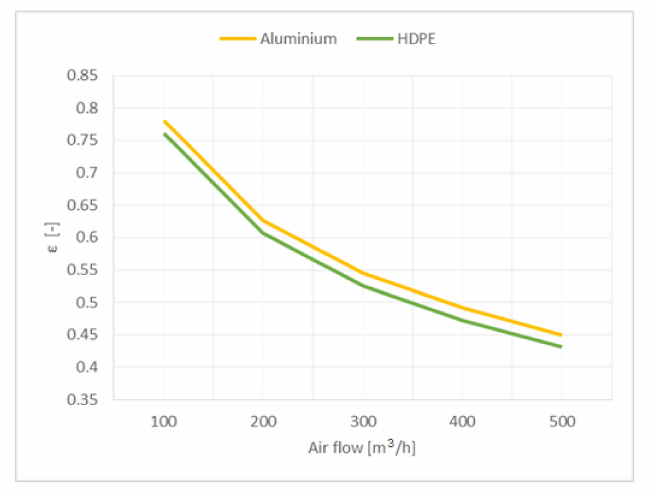
Figure 18. Evolution of the heat exchanger efficiency for Aluminum and HDPE absorber.